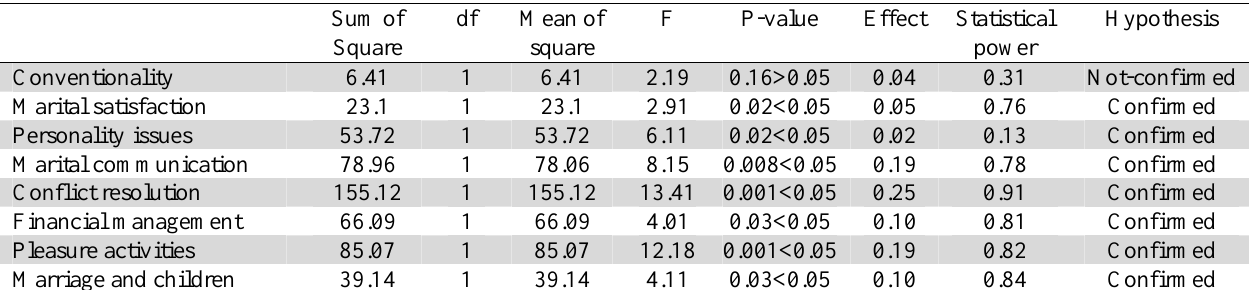
The results of ANOVA test